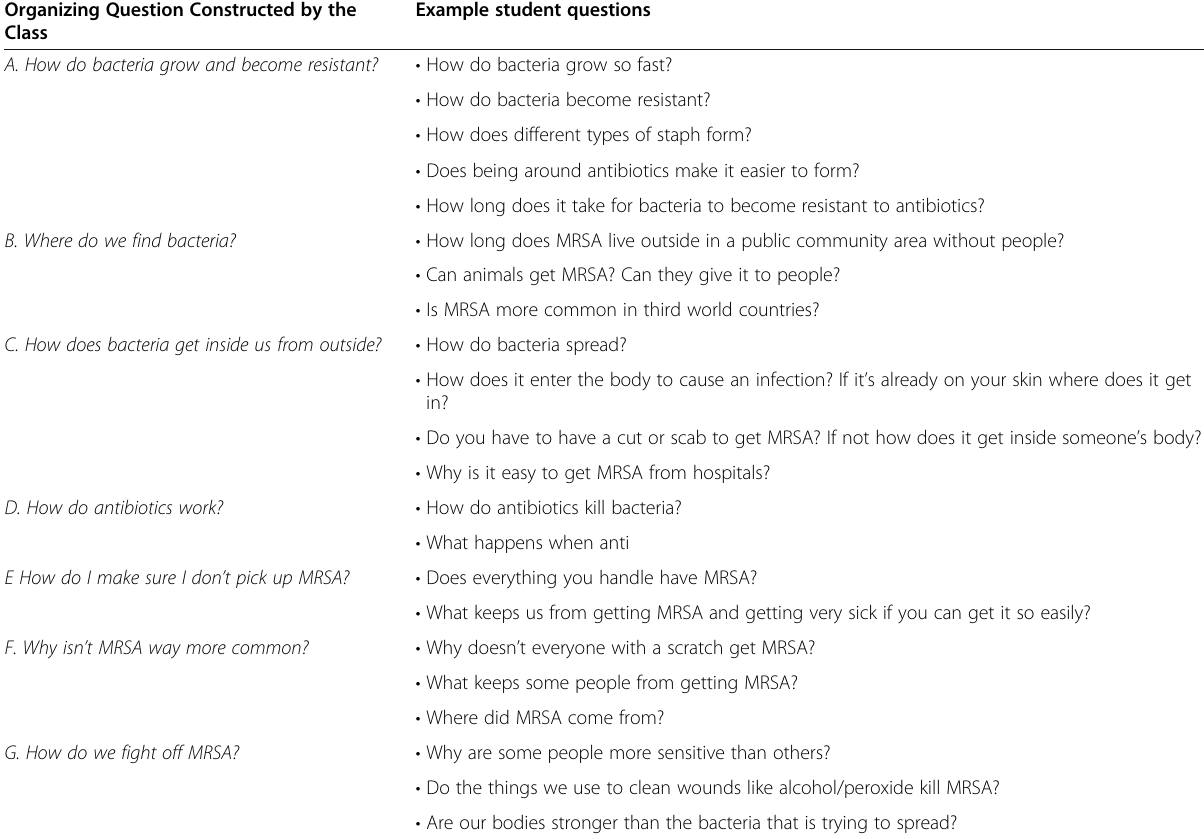
Table 1 A Sample of Question Themes and Questions from High School Classrooms Organizing Question Constructed by the